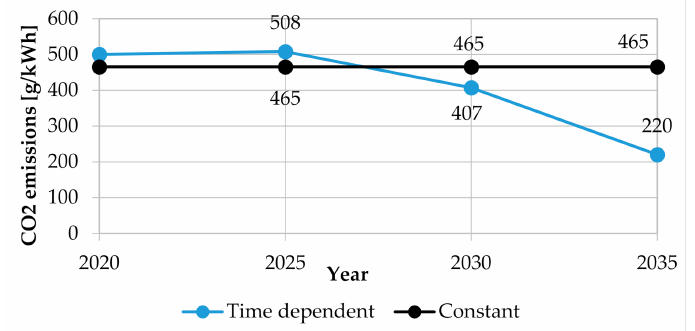
Figure 5. Average CO 2 emission factor in the electricity mix.